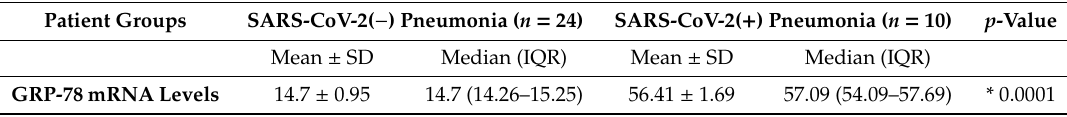
Table 2. GRP78 gene expression levels in the blood of SARS-CoV-2 ( − ) and SARS-CoV-2 ( + ) pneumonia